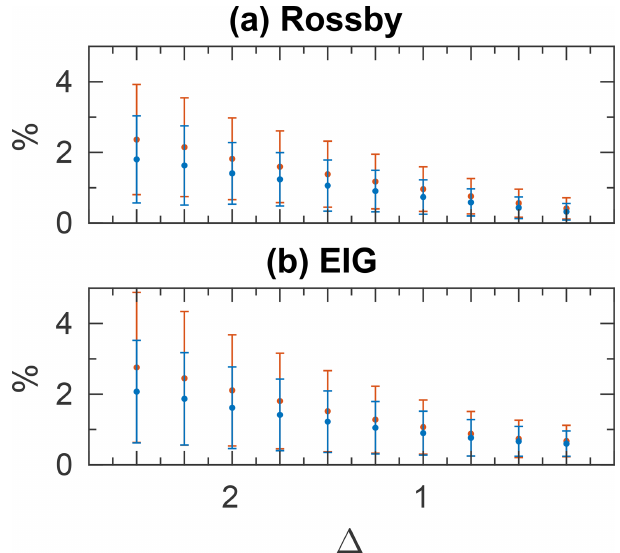
Figure 10. Structure error in absolute value as a function of the grid spacing (cid:49) = (cid:49)λ = (cid:49)φ , from (cid:49) = 2 . 5 ◦ to (cid:49) = 0 . 25 ◦ every 0.25 ◦ . The points correspond to the time averaged structure error over 100 wave periods, and the error bars are determined from the standard deviation. Blue: calculated for the velocity vector u = (u,v) . Red: calculated for the geopotential (cid:56)